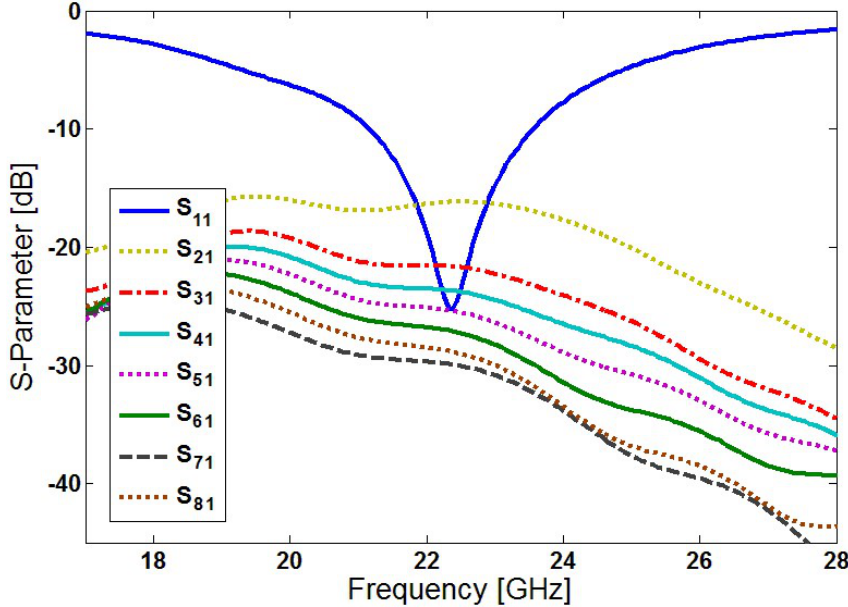
Figure 7. S parameters for the proposed phased array.